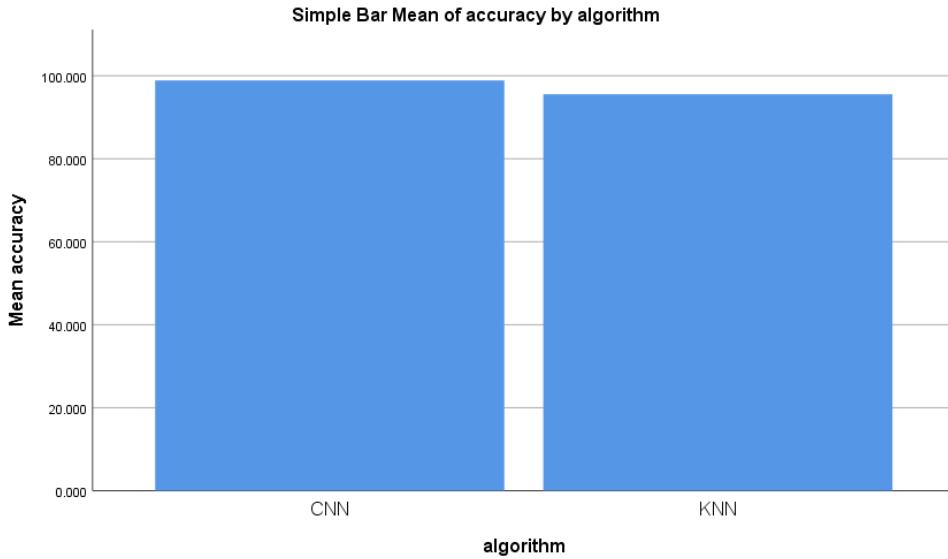
Figure 5. Accuracy mean for CNN and KNN performance measure. From the comparison experiment of the forward-propagation workflow of the CNN and KNN algorithms, the mean precision was also compared. The figure illustrates the comparison of mean precision. A statistical difference was observed between the compar- ison of the mean accuracy of the forward-propagation workflow of the CNN and KNN algorithms. Figure 6 illustrates the graphical difference between the CNN and KNN algo- rithms. Figure 6. Precision mean for the CNN and KNN algorithms ’ performance measure.